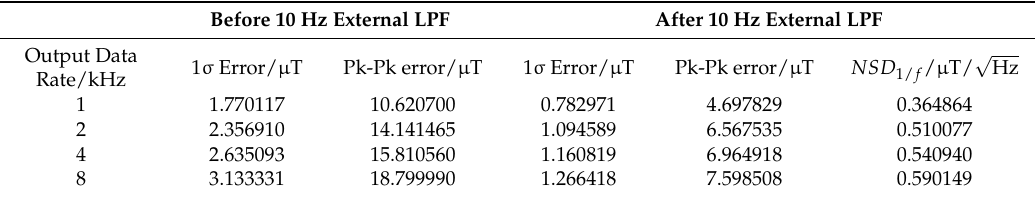
Table 3. Standard deviation and peak to peak noise performance figures for Offset Fluctuation and Drift.